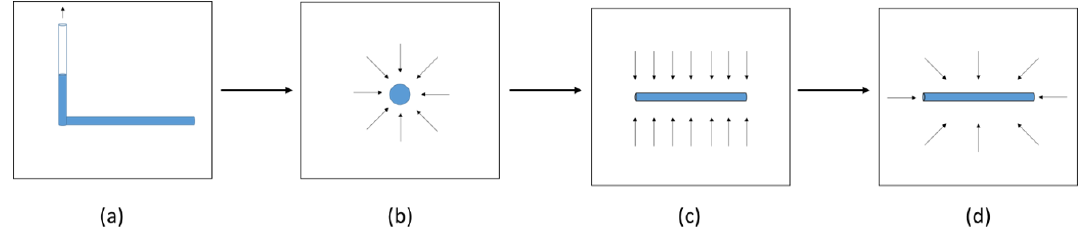
Figure 6. Schematic diagram of different flow stages in horizontal well test [21]: ( a ) Wellbore storage stage; ( b ) Initial radial flow stage; ( c ) Linear flow stage; ( d ) Later quasi-radial flow stage. The arrow represents liquid flow, the blue strip represents horizontal well, and the blue circle represents horizontal well cross section.